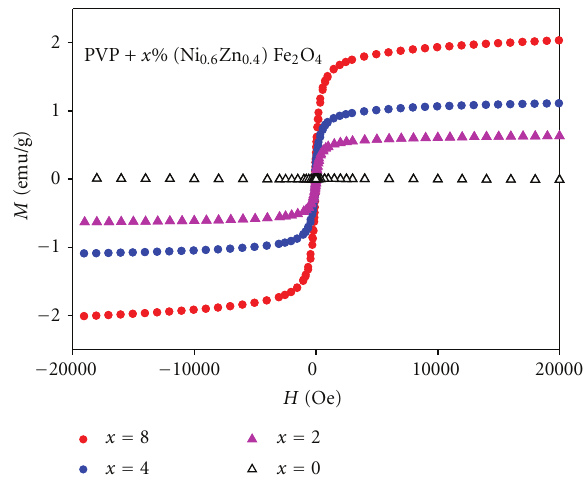
Figure 7: Field dependence of magnetization for PVP-based nanocomposite fibers.